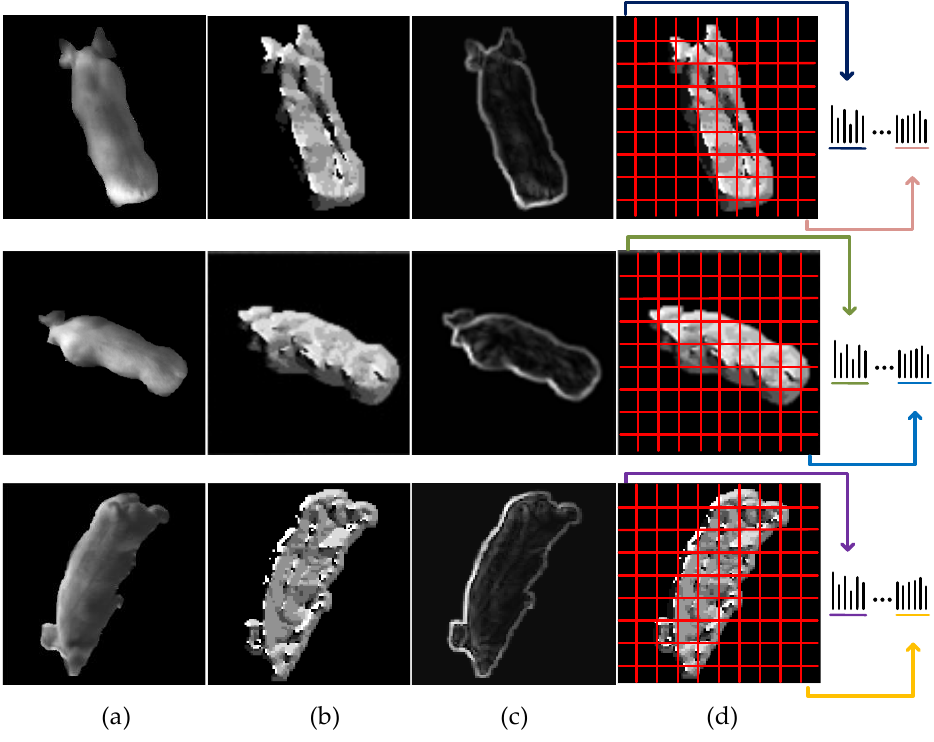
Figure 9. The local structure information coding process. ( a ) The gray images; ( b ) the main directional images; ( c ) the intensity difference of the main direction; ( d ) the coded images.